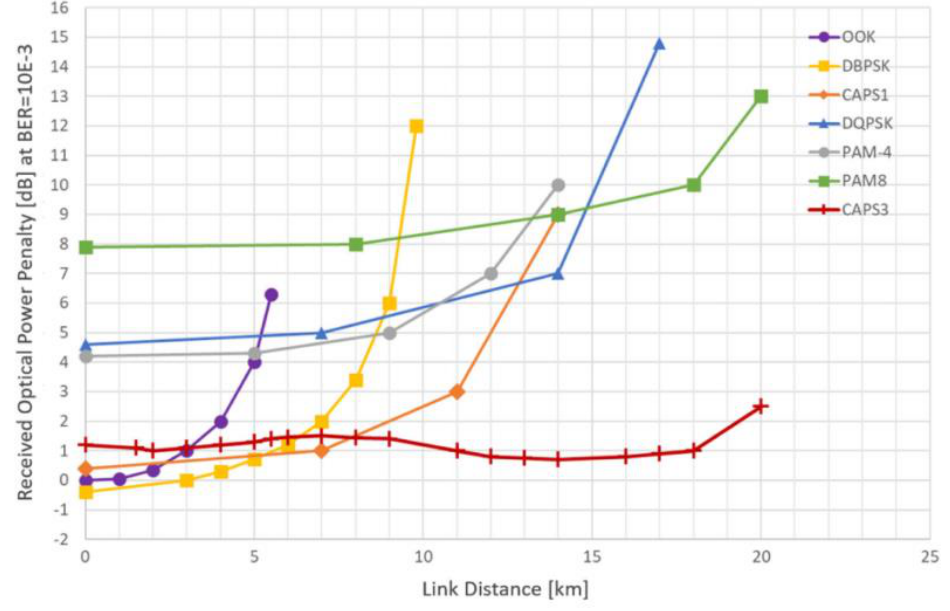
Figure 33. Power penalty of various modulation formats versus link distance [87].